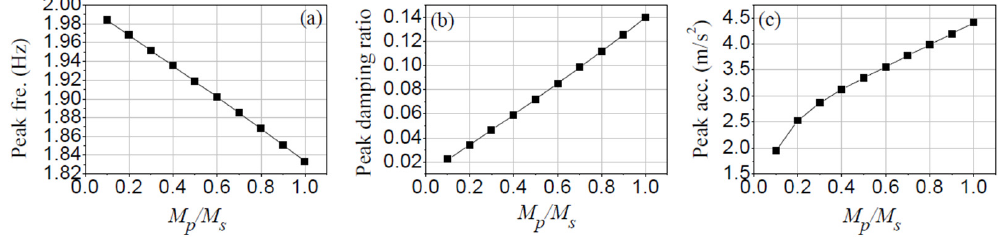
Figure 8. Dynamic property peaks under different mass ratios between crowd and structure: ( a ) structural frequency is approximately linearly decreased along with the growth of mass ratio; ( b ) structural damping is approximately linearly increased along with the growth of mass ratio; ( c ) the increase of mass ratio result in the persistent growth of peak acceleration under resonant